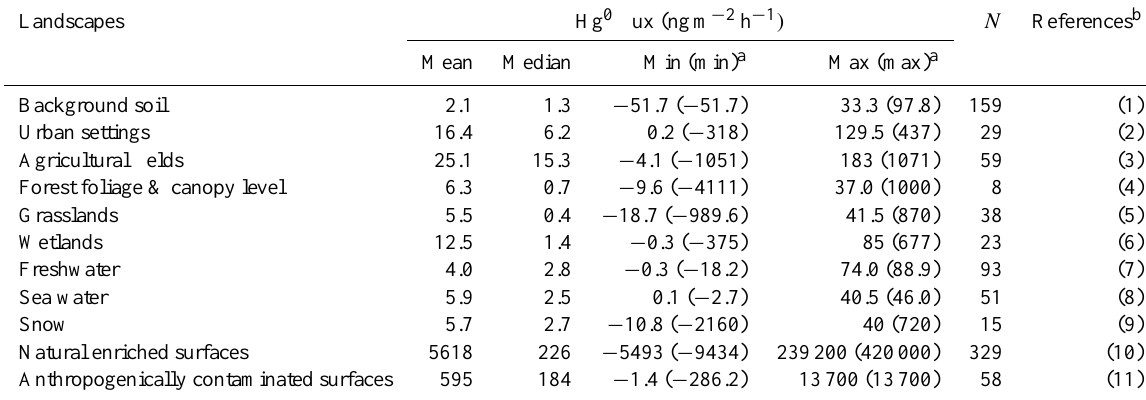
Table 1. A statistical summary of field in situ observed Hg 0 flux reported in the literature.